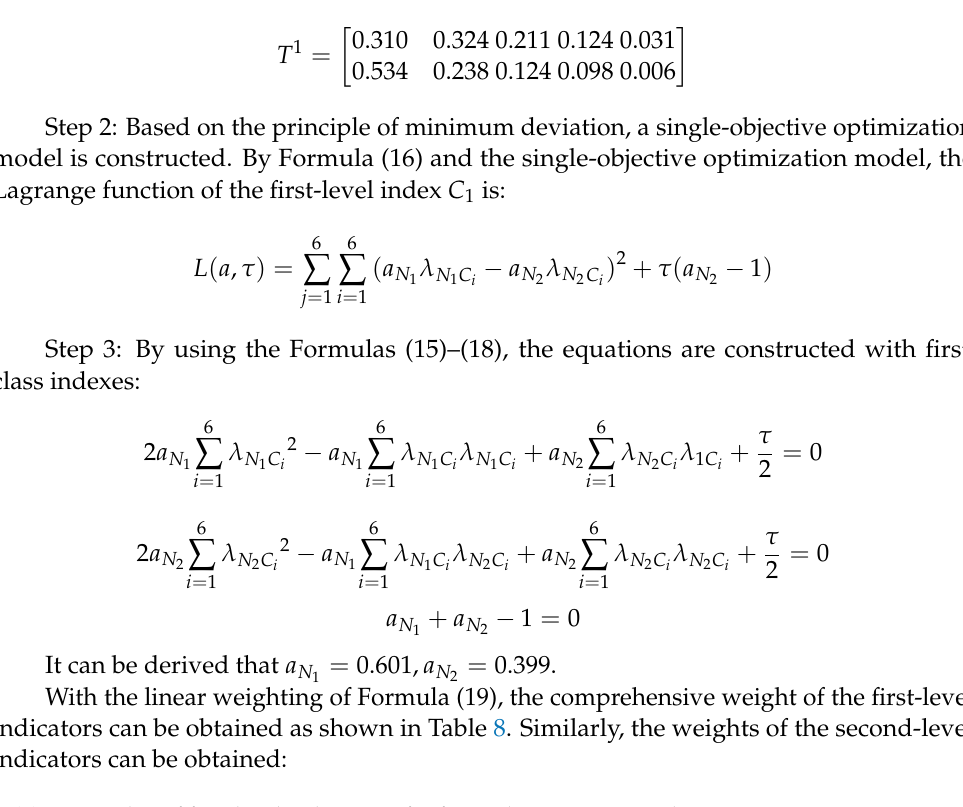
Table 8. Weights of first-level indicators of safety risks in TBM tunnel construction.